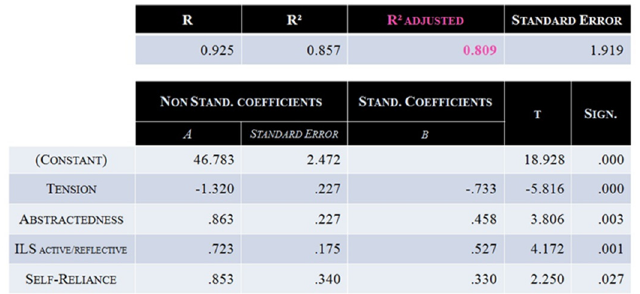
Fig 5. Characteristics of Model ] 2. This model included 4 factors: Tension, Abstractness, the “ Visual/ Verbal ” dimension of the Learning Style and Self-Reliance. Abstractness, the “ Visual/Verbal ” dimension of the Learning Style and Self-Reliance had positive weights. Tension was the only factor to have a negative weight. This model enabled to explain 80.9% of MI-BCI performance variance [ R 2 adj = 0.809, p <